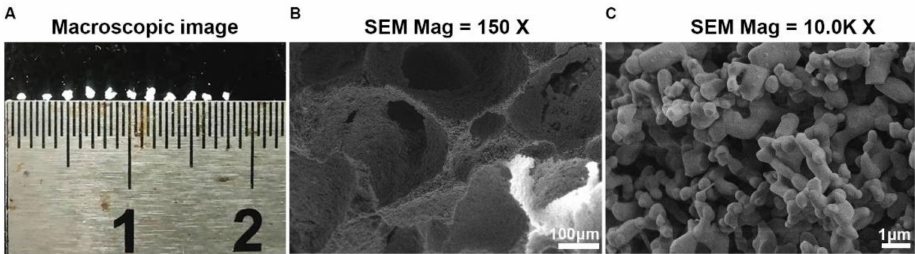
Figure 1. Morphological characteristics of BCP ceramics. ( A ) Macroscopic image showed the sizes of BCP particles ranged from 0.5–0.8 mm. ( B , C ) SEM image showed the macro- and micro-pores ranged from 20–400 µ m and 0.3–1.8 µ m, respectively. Scale bar: 100 µ m and 1 µ m, respectively.